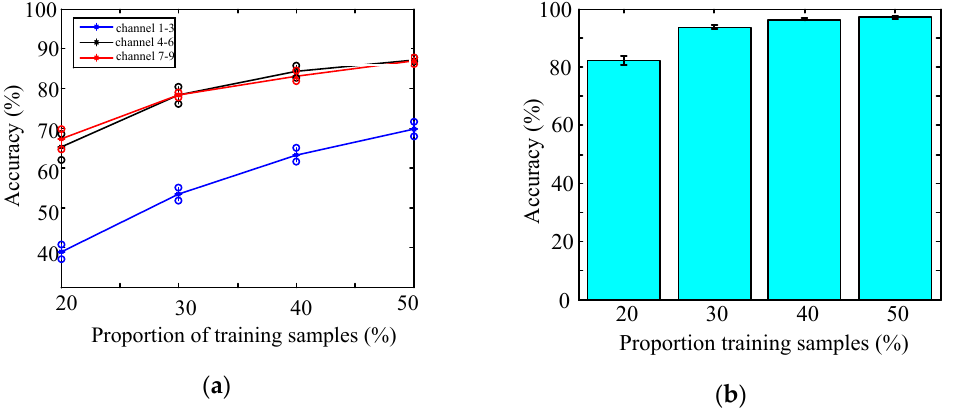
Figure 5. The accuracy of the proposed method under different proportions of training samples: ( a ) using different channels’ data and ( b ) all nine channels’ data.